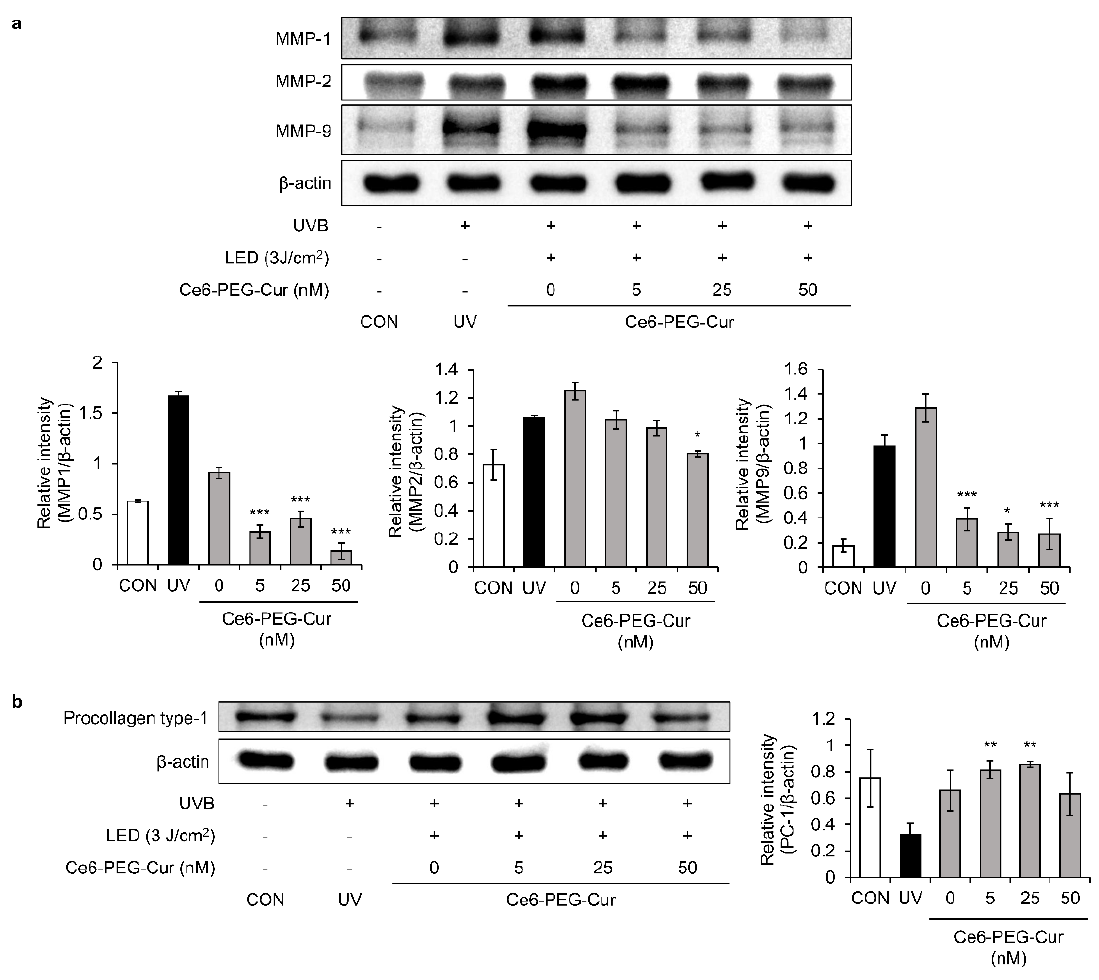
Figure 7. The effect of Ce6-PEG-curcumin-mediated PDT on ( a ) the MMP-1, MMP-2, and MMP-9 expression and ( b ) procollagen type I levels in the dorsal skin of UVB-irradiated mice. Results are expressed as mean ± SD. * p < 0.05, ** p < 0.01, and *** p < 0.001 vs. UVB-irradiated control.